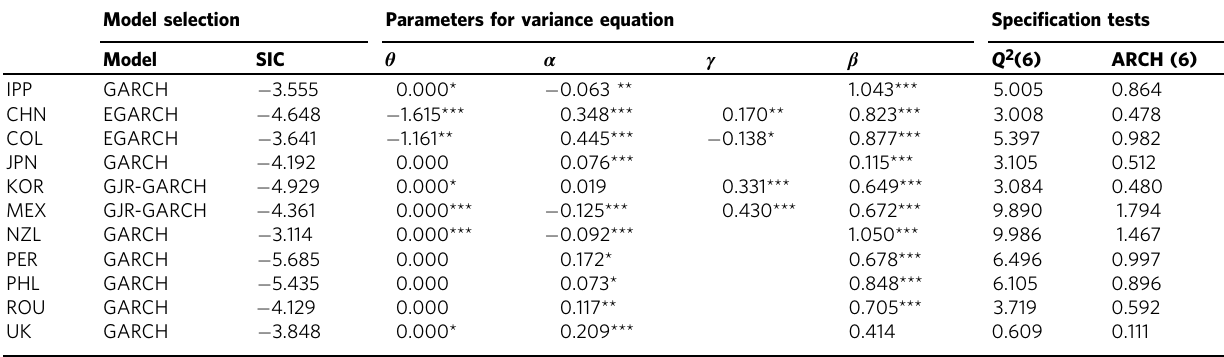
Table 5 Empirical results of the GARCH model. Model